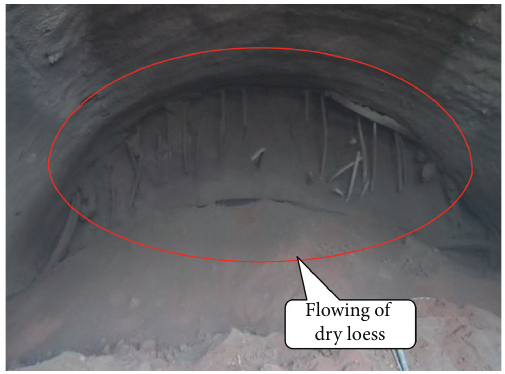
Figure 5: The dry loess flowing on excavation face.